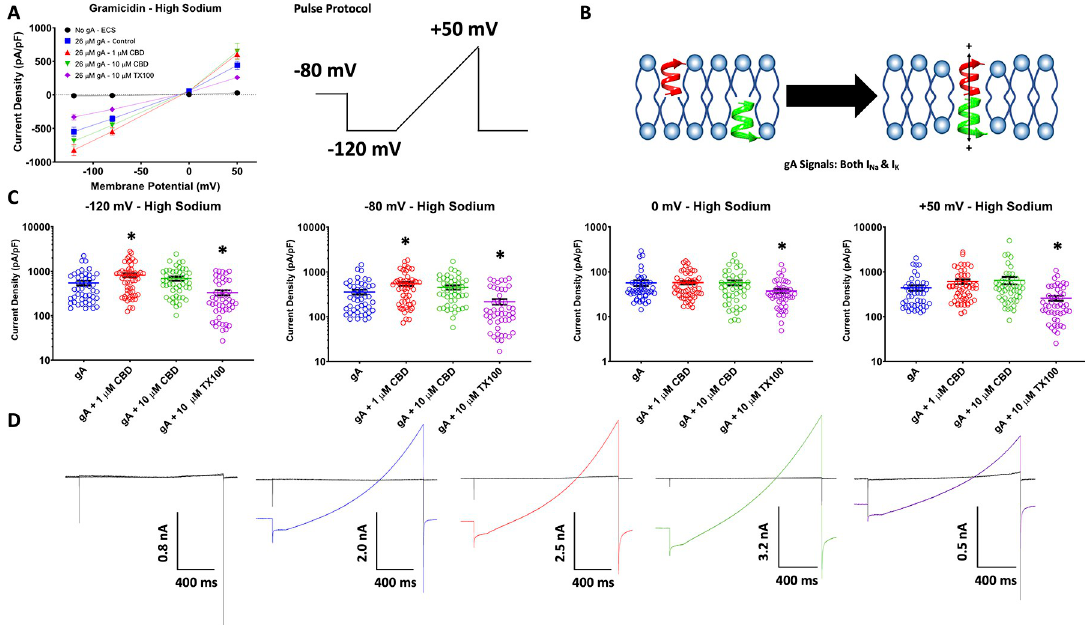
Fig 1. High sodium voltage-clamp, gramicidin (gA). (A) Shows the averaged cationic current densities of gramicidin in the presence/ absence of CBD at 1 and 10 μ M, and TX100 at 10 μ M, on the left (in pA/pF, ECS: -120 mV = -13.6 ± 6.3, -80 mV = -10.1 ± 5.0, 0 mV = 5.2 ± 0.5, +50 mV = 30.0 ± 11.0, n = 36; gA: -120 mV = -547.8 ± 66.2, -80 mV = -357 ± 44, 0 mV = 56.5 ± 8.1, +50 mV = 441.1 ± 60.5, n = 47; 1 μ M CBD: -120 mV = -820.1 ± 83.2, -80 mV = -543 ± 55.8, 0 mV = 57.7 ± 5.2, +50 mV = 607.4 ± 72.2, n = 56; 10 μ M CBD: -120 mV = -687.0 ± 70.3, -80 mV = -452.8 ± 47.4, 0 mV = 57.1 ± 7.1, +50 mV = 649.2 ± 118.8, n = 49; 10 μ M TX100: -120 mV = -330.8 ± 43.8 ± , -80 mV = -216.5 ± 30.4, 0 mV = 37.3 ± 4.0, +50 mV = 259.4 ± 32.8, n = 48). The ramp voltage protocol is shown on the right. (B) Shows a cartoon diagram of how gramicidin monomers are thought to dimerize and form channels. (C) Shows quantification of the data shown in (A), stars indicate statistical significance. (D) Shows the associated current traces.